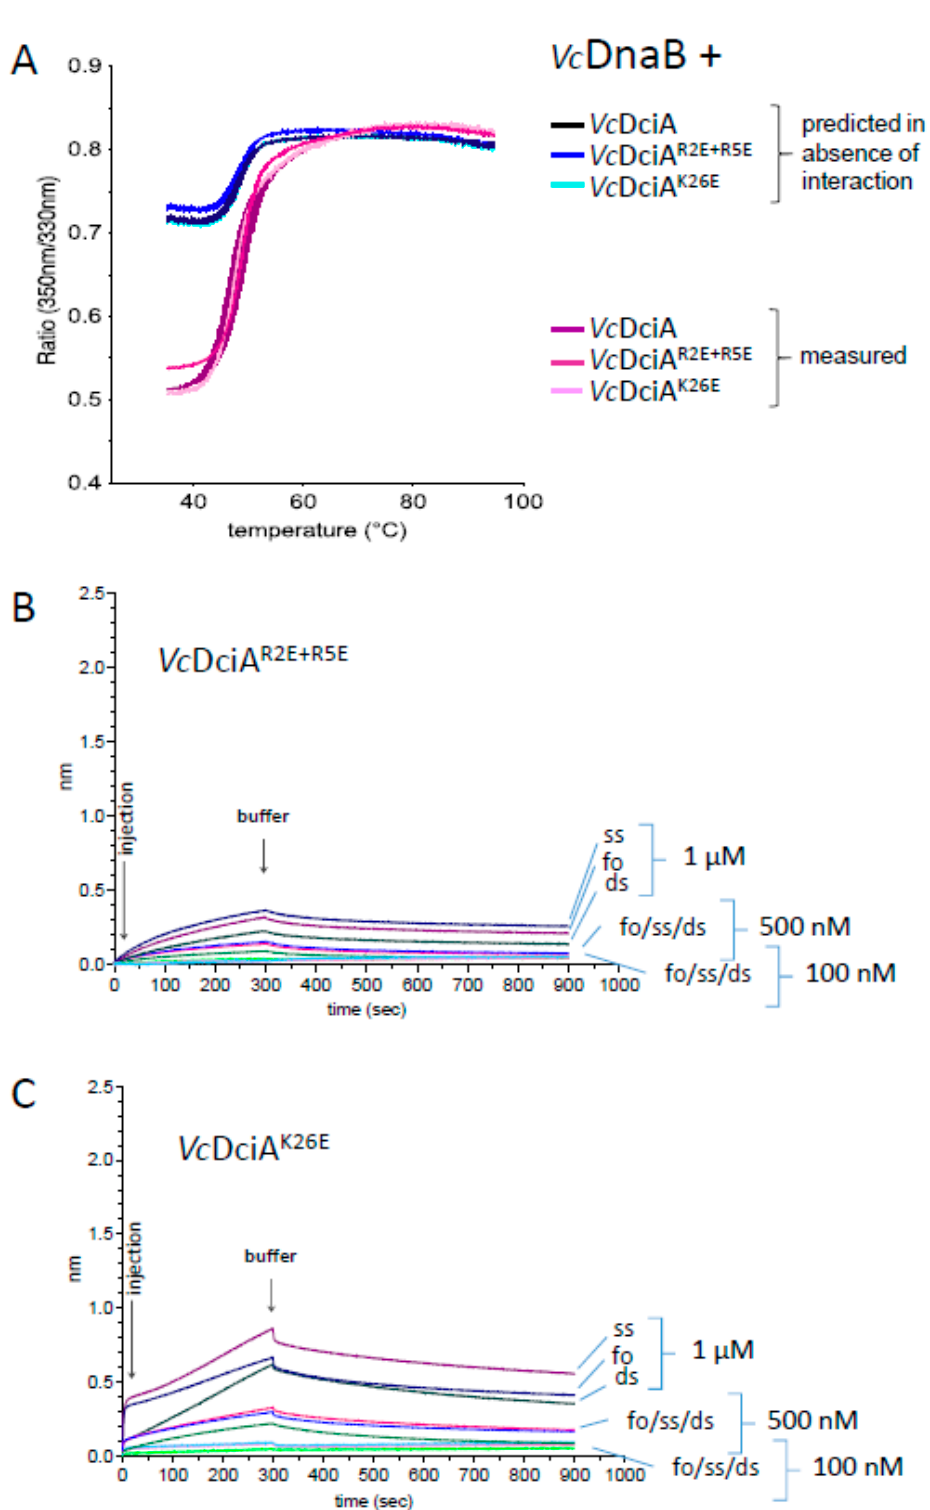
Figure 5. Biochemical validation of the R2, R5, and K26 residues for their interaction with the DNA. ( A ) Characterization of the interaction between Vc DnaB and Vc DciA, and Vc DciA R2E+R5E and Vc DciA K26E by Tycho NT.6 analysis. In 3 shades of pink are reported the 350/330 nm ratio obtained for the 3 complexes and in 3 shades of blue are reported the predicted ratio for an absence of solvent protection. The curves correspond to the mean ± SEM of three analyses. The interactions of Vc DciA R2E+R5E ( B ) and Vc DciA K26E ( C ) with single- and double-stranded DNA, and with a fork-mimicking DNA, using BLI technology, are observed as for Vc DciA (Figure 1).